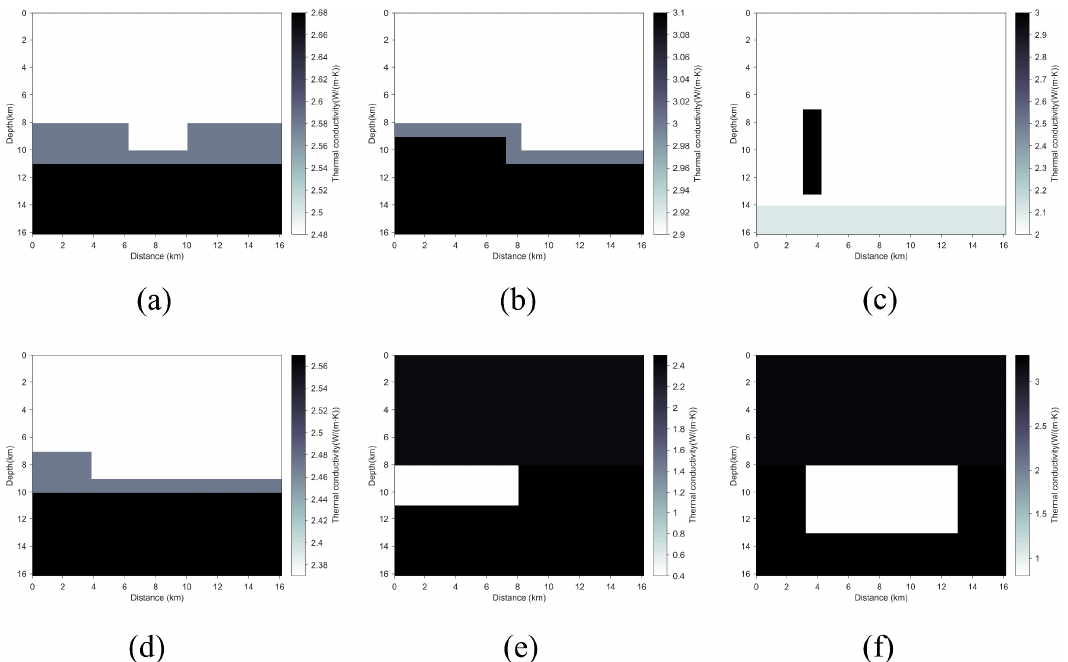
Figure 5. Thermal conductivity of six geological models ( a – f ) for the training data set: ( a ) Graben model, ( b ) pleated–structure model, ( c ) magmatic intrusion model, ( d ) platform model, ( e ) magmatic intrusion model, ( f ) magmatic intrusion model.